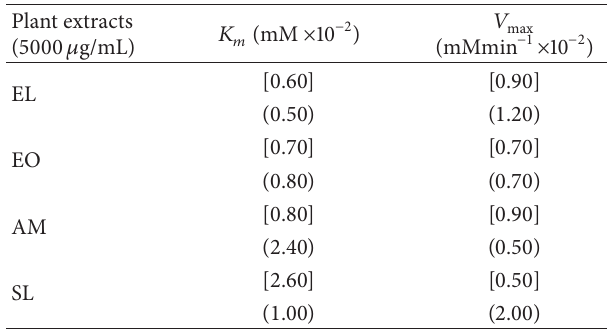
Starch concentration ( % ) Glucose concentration (mM) Figure5:Percentagestarchofreactionmixtureandglucoseconcen- tration of dialysate in the presence of methanolic extracts. ∗ Values [starch (%) concentration] significantly ( 𝑃 < 0.05 ) higher than neg- ative control. † Values [glucose (mM) concentration] significantly ( 𝑃 < 0.05 ) lower than negative